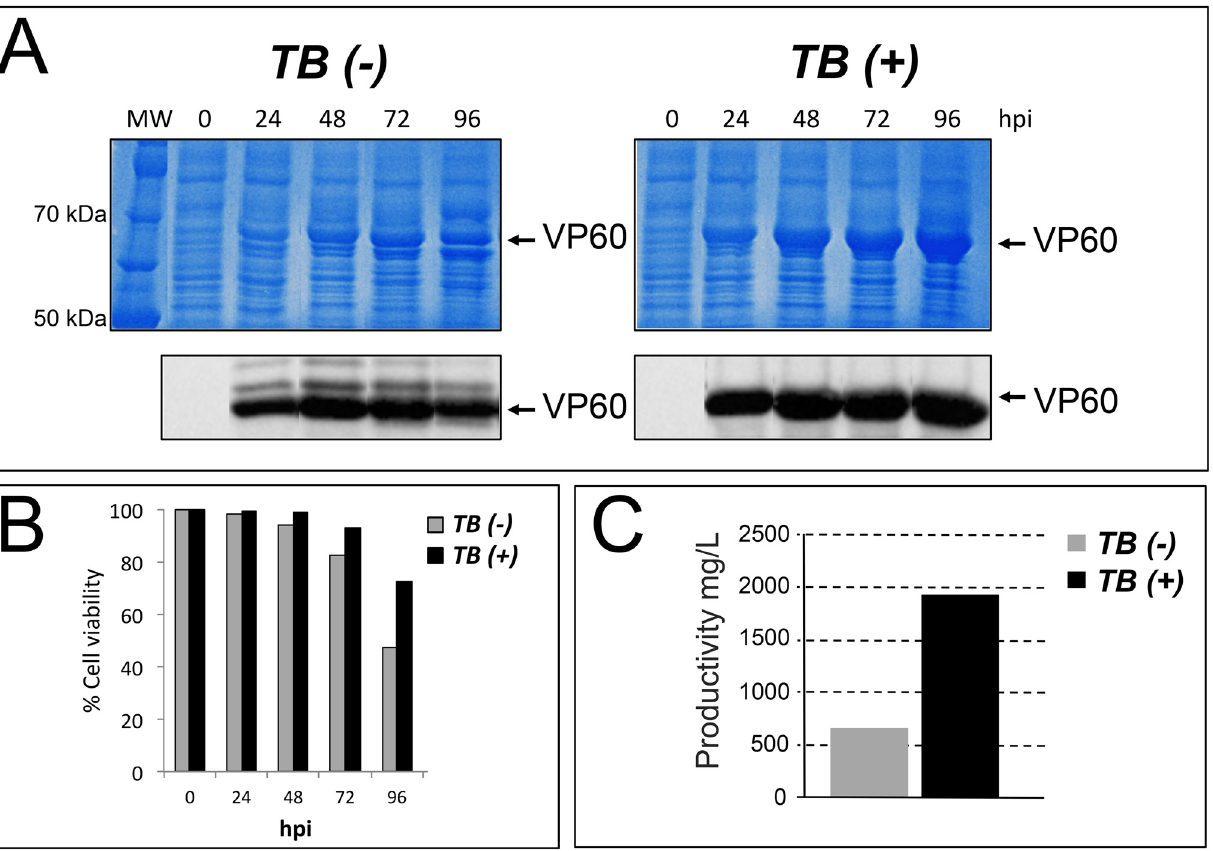
Fig 3. Production of the RHDV-VP60 protein in Sf9 cells grown in suspension and infected by a conventional TB(-) or by a TB (+) baculovirus expressing the VP1 and VP2 genes from RHDV genogroup 1. A) Coomassie blue staining of SDS-PAGE gels resolving protein extracts obtained from infected cells with TB(-) or TB(+) baculoviruses and collected from 0 to 96 hpi. The same samples were submitted to a Western blot using a monoclonal antibody against the RHDV-VP60 antigen. B) Infected cells viability at different hpi with TB(-) and TB(+) baculoviruses expressing the RHDV-VP60 protein, analyzed by Trypan blue staining. This panel represents the mean values of three different experiments. C) Calculation of VP60 protein productivity in Sf9 cells infected by TB(-) and TB(+) baculoviruses at the optimal production time in each case (72 hpi for TB(-) and 96 hpi for the TB(+) baculovirus).